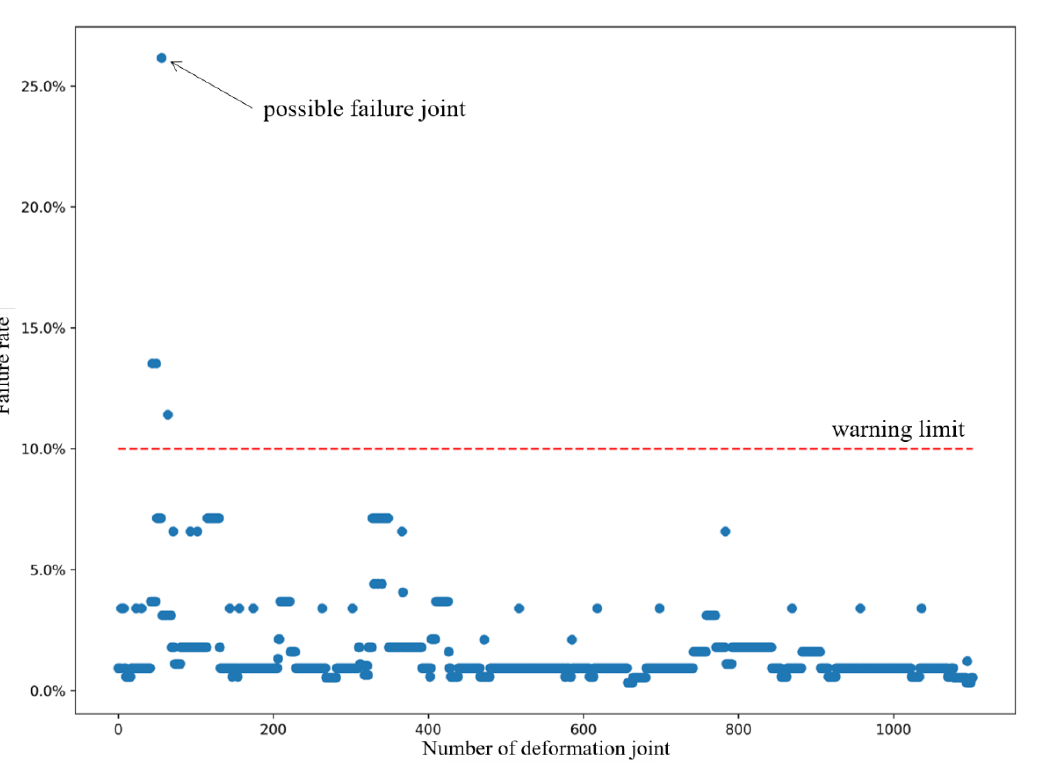
17 of 21 Figure 8. Posterior distributions of the model parameters. Table 4. Posterior estimates of the model parameters. Parameters